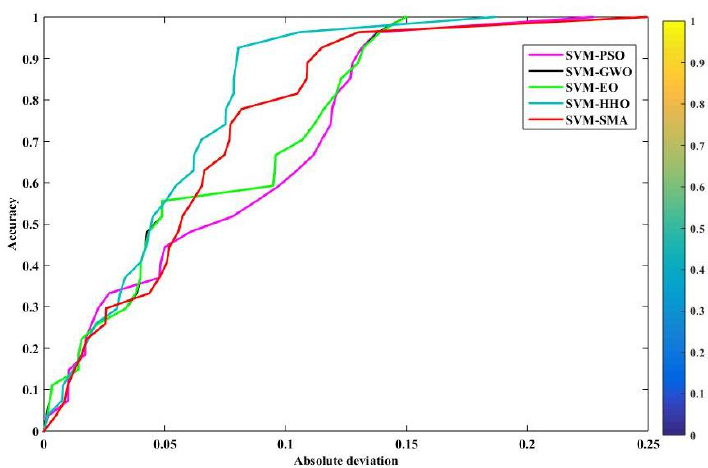
Figure 10. REC curves for testing. Table 8. Values of AOC.